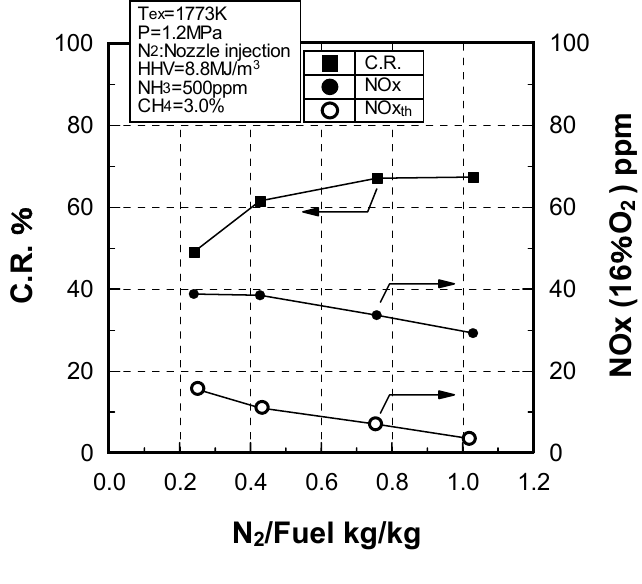
Figure 81. Effect of nitrogen injection flow rate from burner on NOx emission